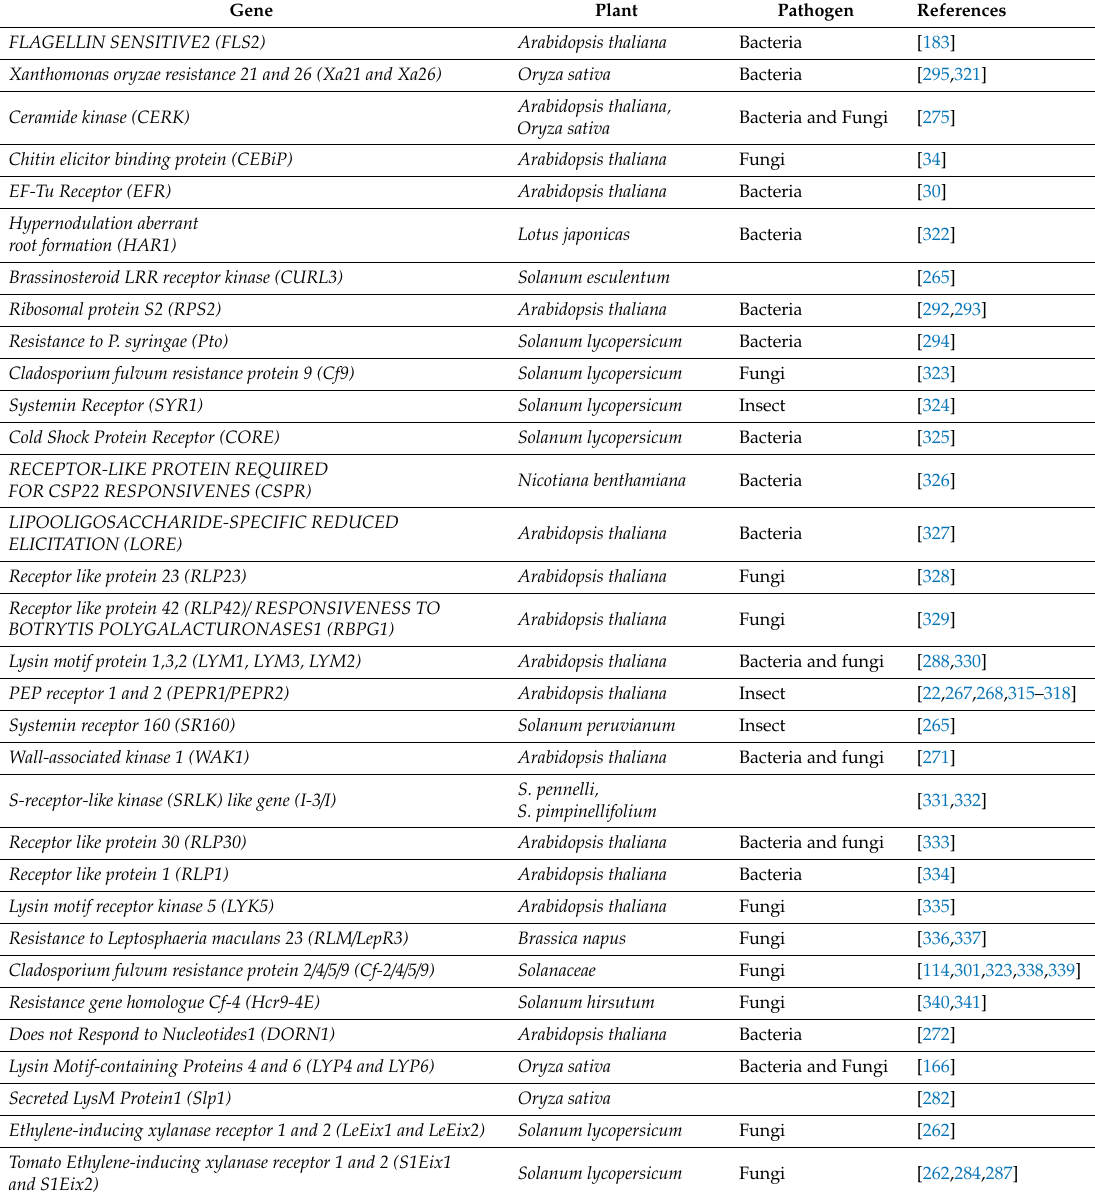
Table 2. List of identified receptor molecules in plants against bacteria, fungi, and insects.